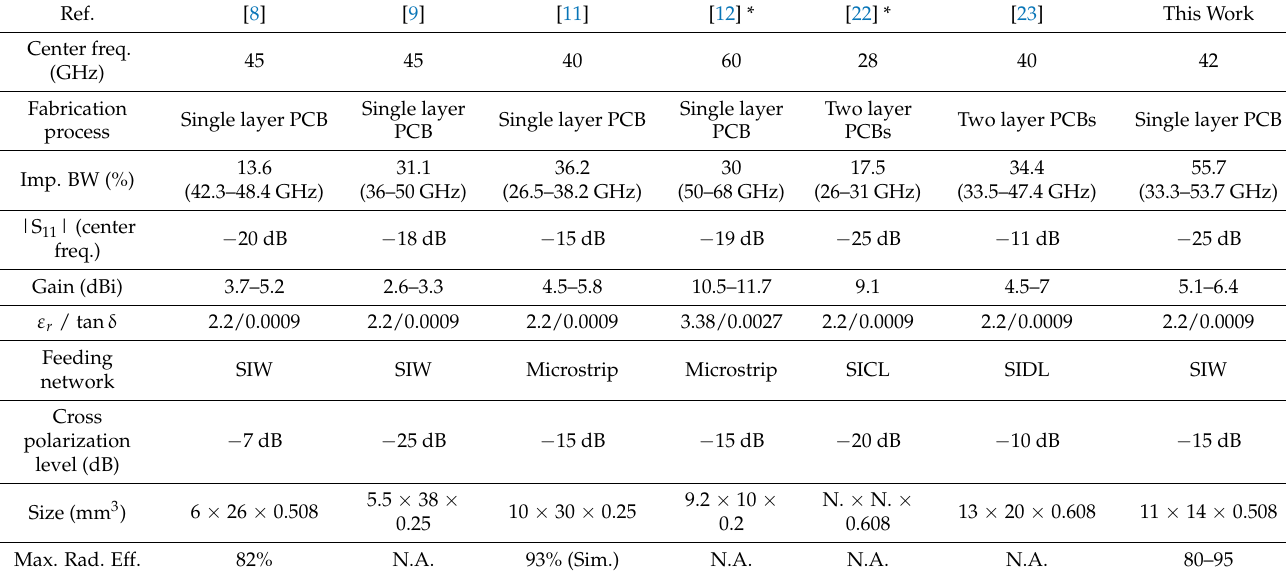
Table 2. Comparison among planar millimeter-wave dipole